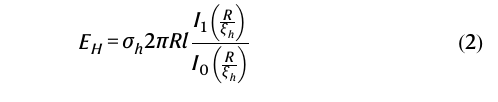
Fig. 7 | Dependence of cluster formation energy on cluster size (per 1 FP). Dependenceofthe energy of cluster formation on its size for thesuperoptimalFP concentration x =0.3. Additional contributions to clustering are related to dipole- dipole interactions and hydrogen bonds between contacting FPs, but they are not accounted for inthese calculations. Source data are providedas a Source Data fi